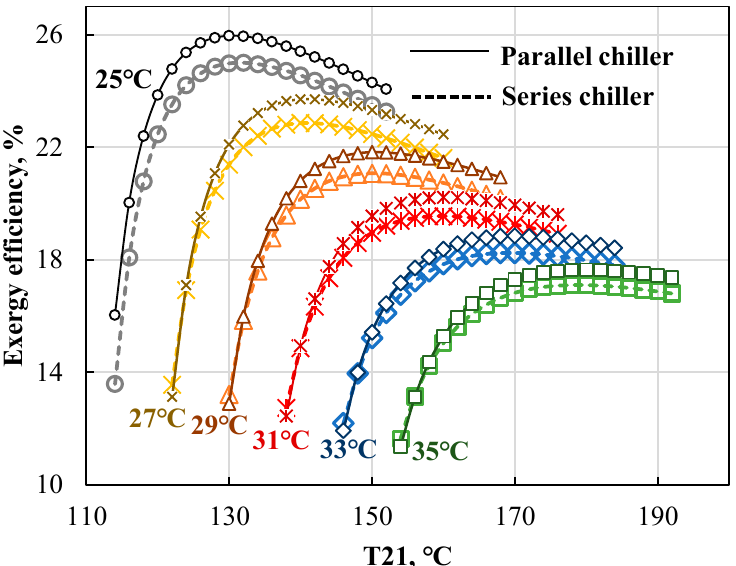
Figure 5. Variation of exergy efficiency with two types of absorption chillers as functions of cooling temperature and steam temperature (T21).